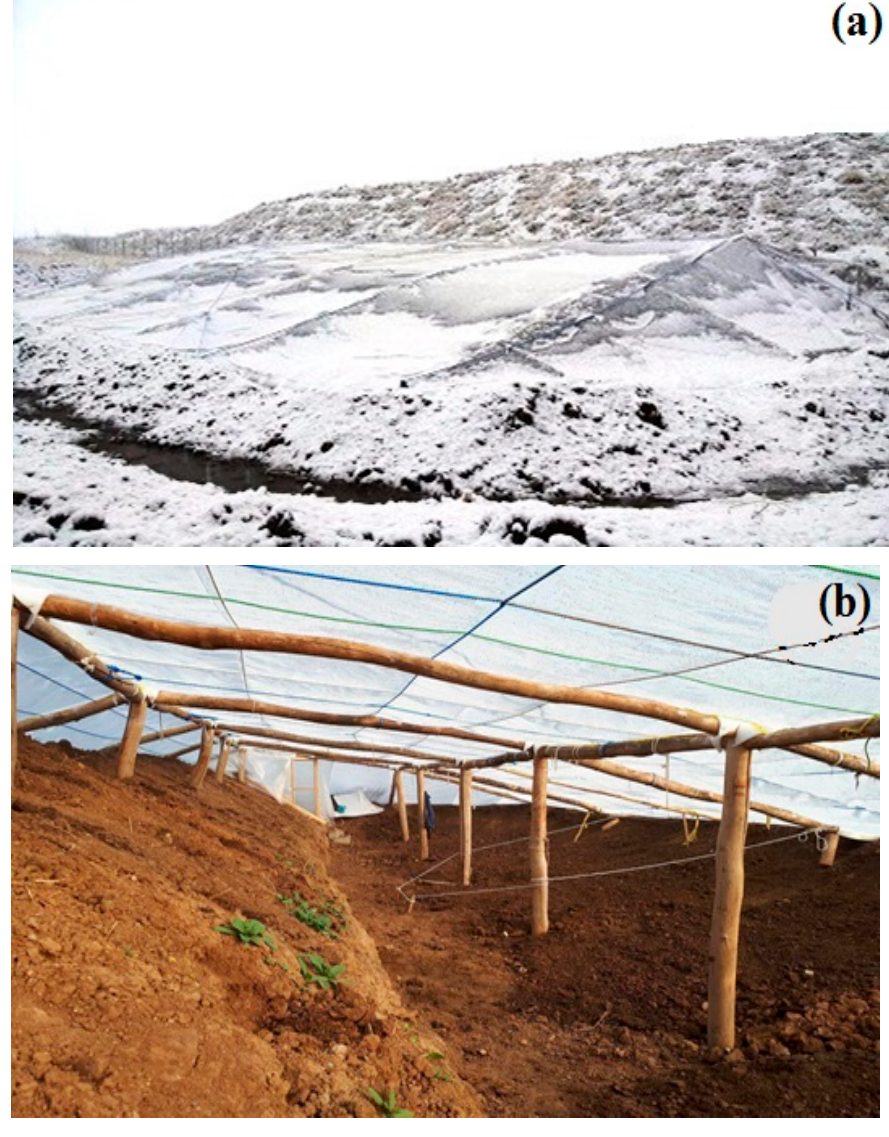
Figure 6. Outside ( a ) and inside ( b ) of greenhouse in winter.